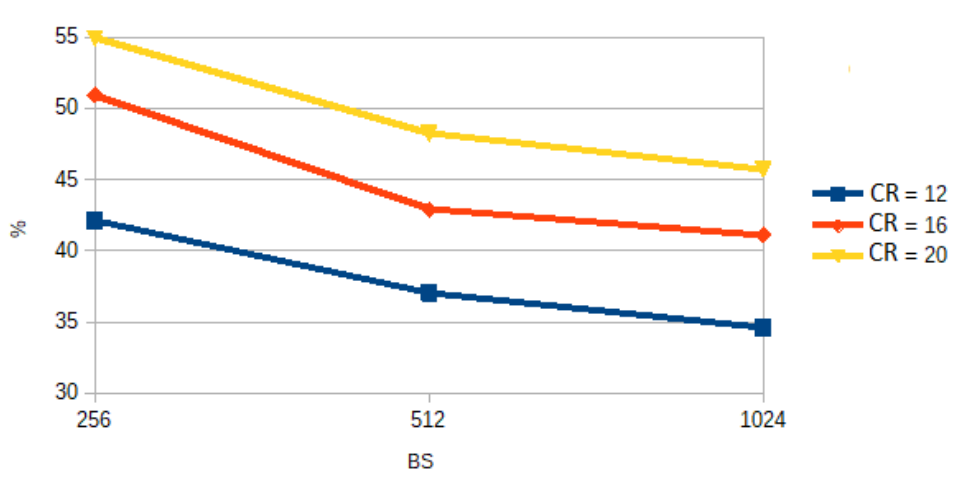
Figure 10. Reduction in the number of FLOPs (%) using the proposed methodology compared with the execution of both the lossy compression and the anomaly detection processes as two independent